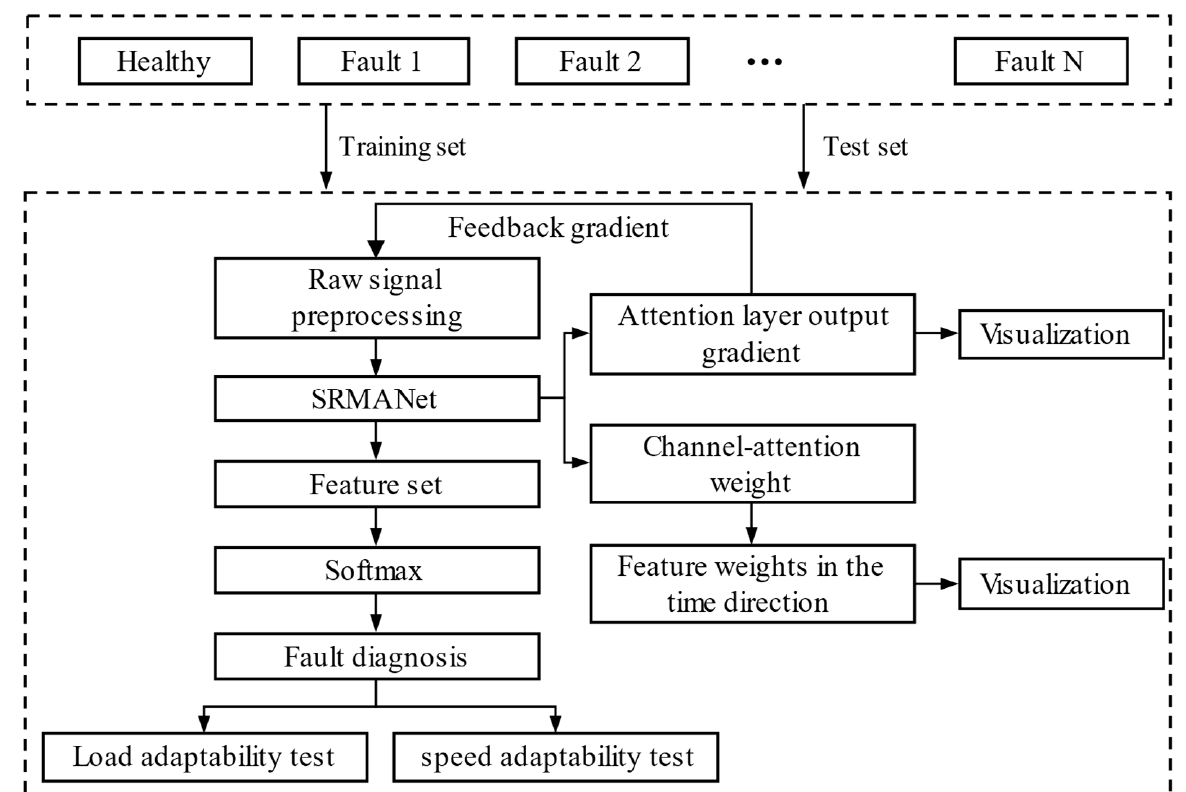
Figure 4. Flow chart of methodology.